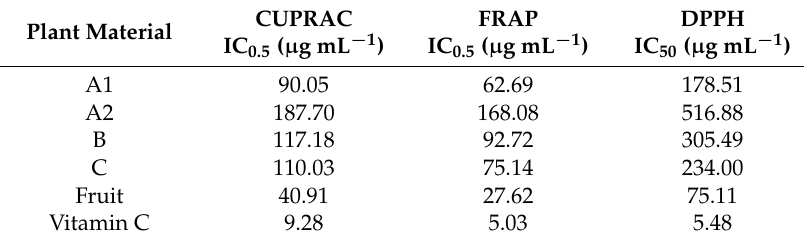
Table 5. The antioxidant effect of four lines of Chaenomeles japonica callus. Plant